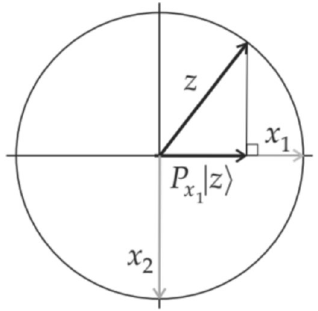
Figure 1. Projective probability: Pr ( x 1 )